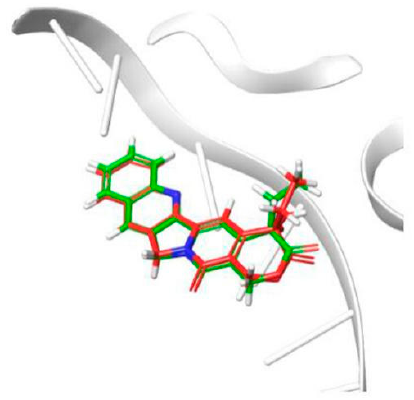
Figure 3. Result of validation for Topo I inhibitor camptothecin (CPT), inside the enzyme active site (derived from PDB ID 1T8I).